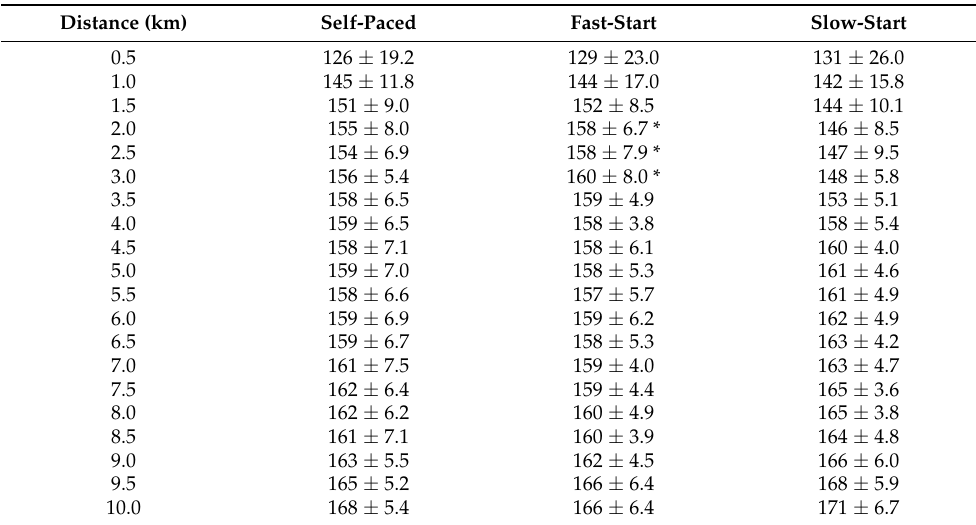
Table 6. Means ± standard deviations of heart rate (bpm) during self-paced, fast-start, and slow-start time trials.